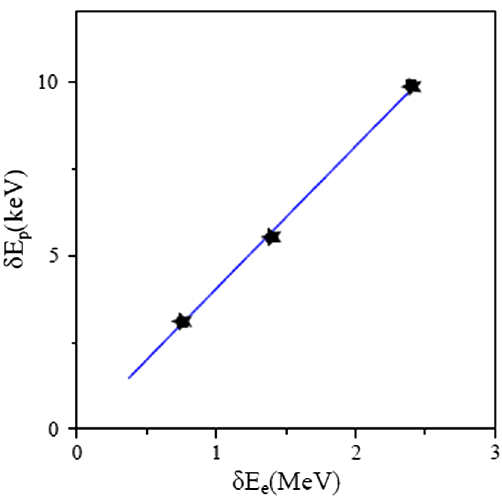
FIG. 5. Spectral density S ¼ dN=dE p as a function of E p in the case of beam (B) for different acceptance angles: